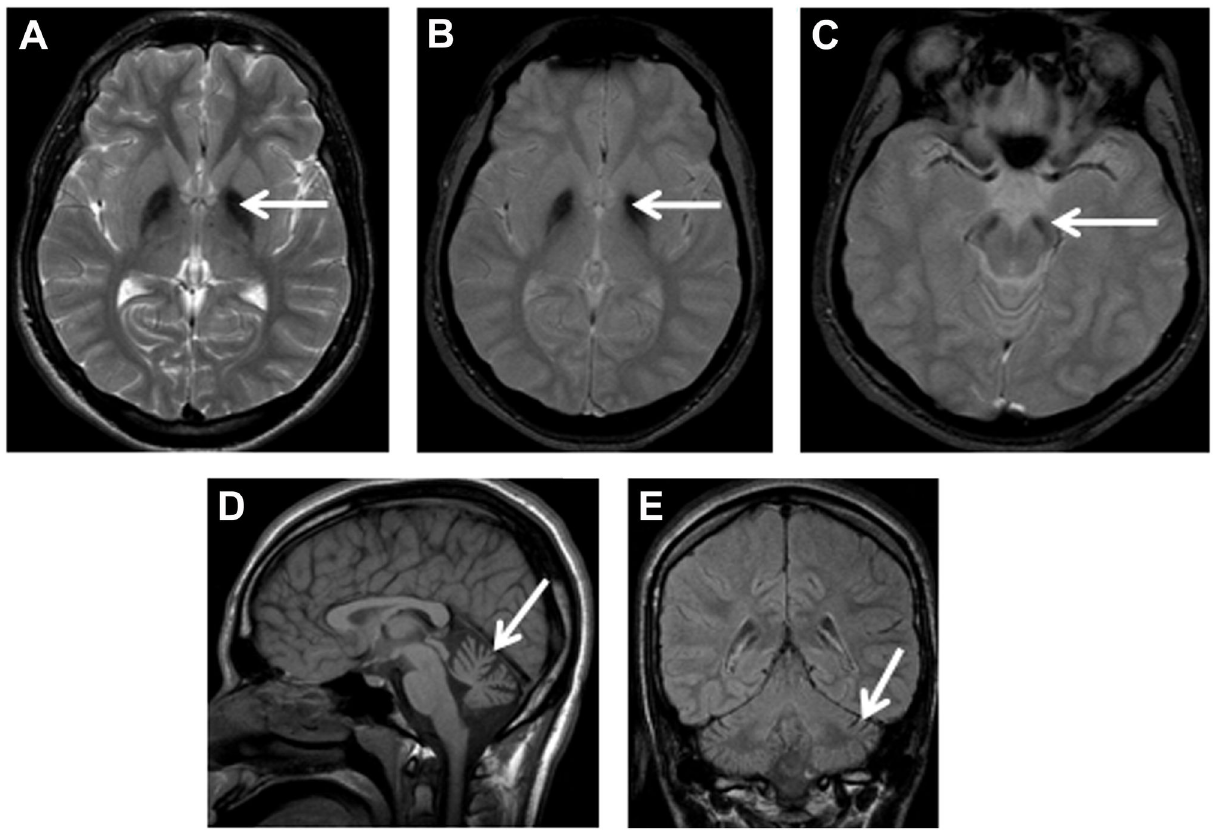
Figure 3. Patient F6 (P3) MRI, age 17 years 5 months. Axial T2-weighted (A), axial gradient (B and C), sagittal T1-weighted (D) and coronal fluid-attenuated inversion recovery (FLAIR, E) sequences highlight iron deposition as reduction in signal intensity in the globus pallidi (arrows in A and B) and substantia nigra (arrow in C). There is also cerebellar cortical atrophy with increased CSF spaces around the cerebellum (arrows in D and